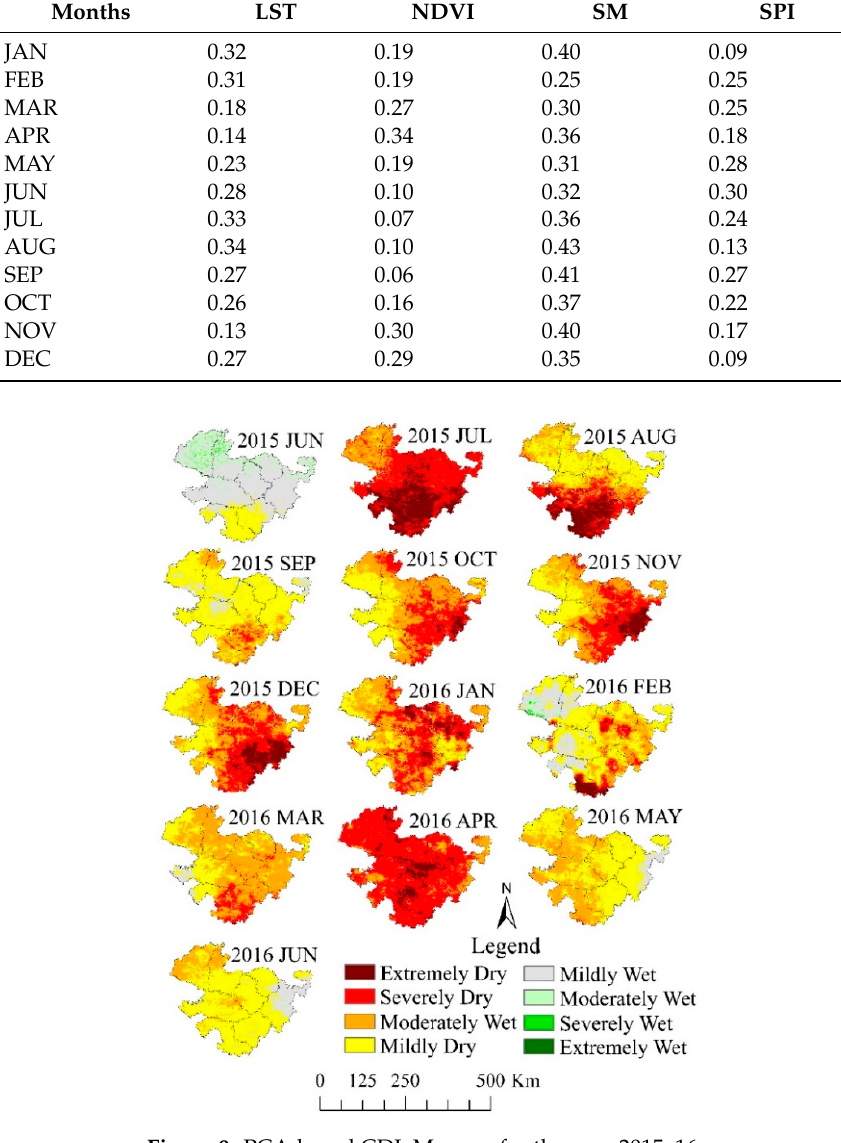
Figure 9. PCA-based CDI_M maps for the year 2015–16 .